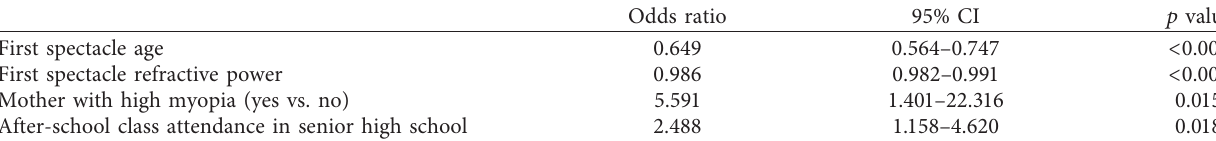
Table 4: Logistic regression analysis for high myopia.